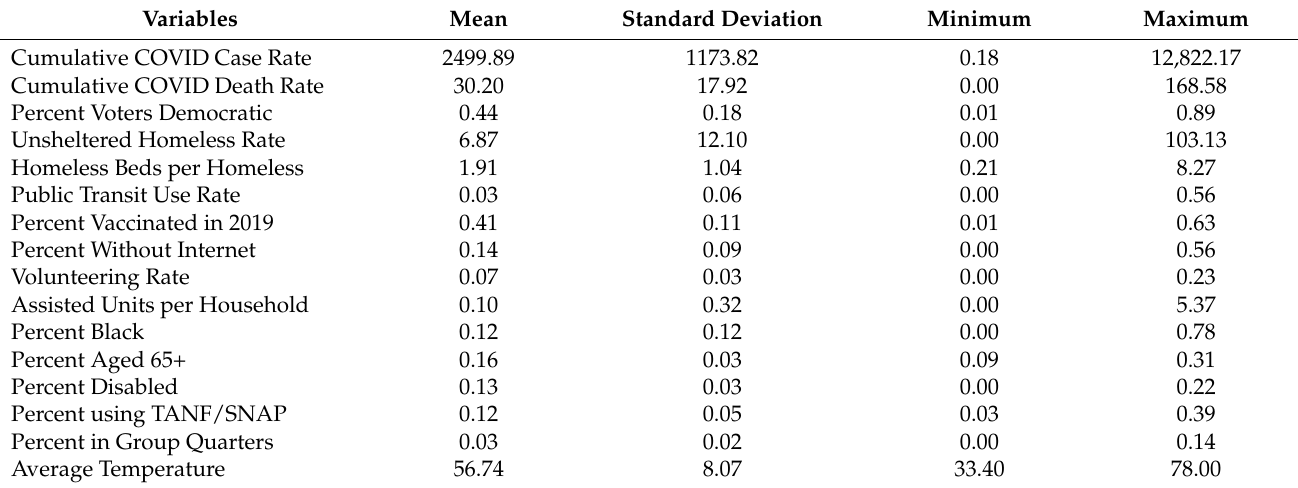
Table 1. Descriptive Statistics at the Continuum of Care